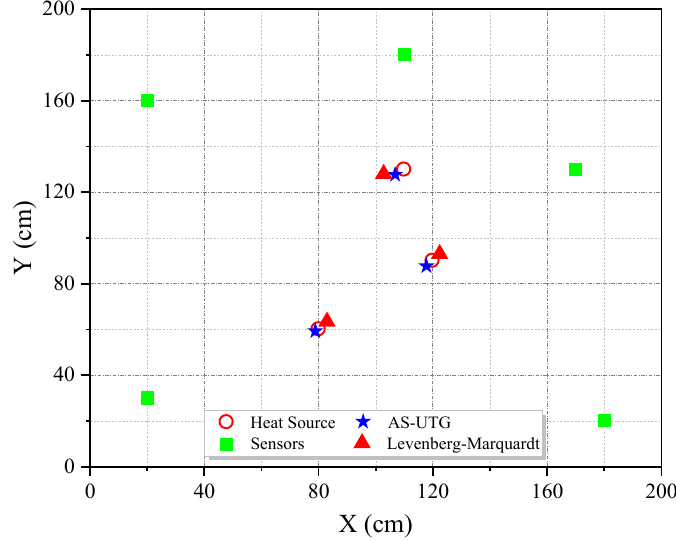
Figure 3. Locations of receivers and calculated results of AS-UTG and inverse results by Levenberg–Marquardt.